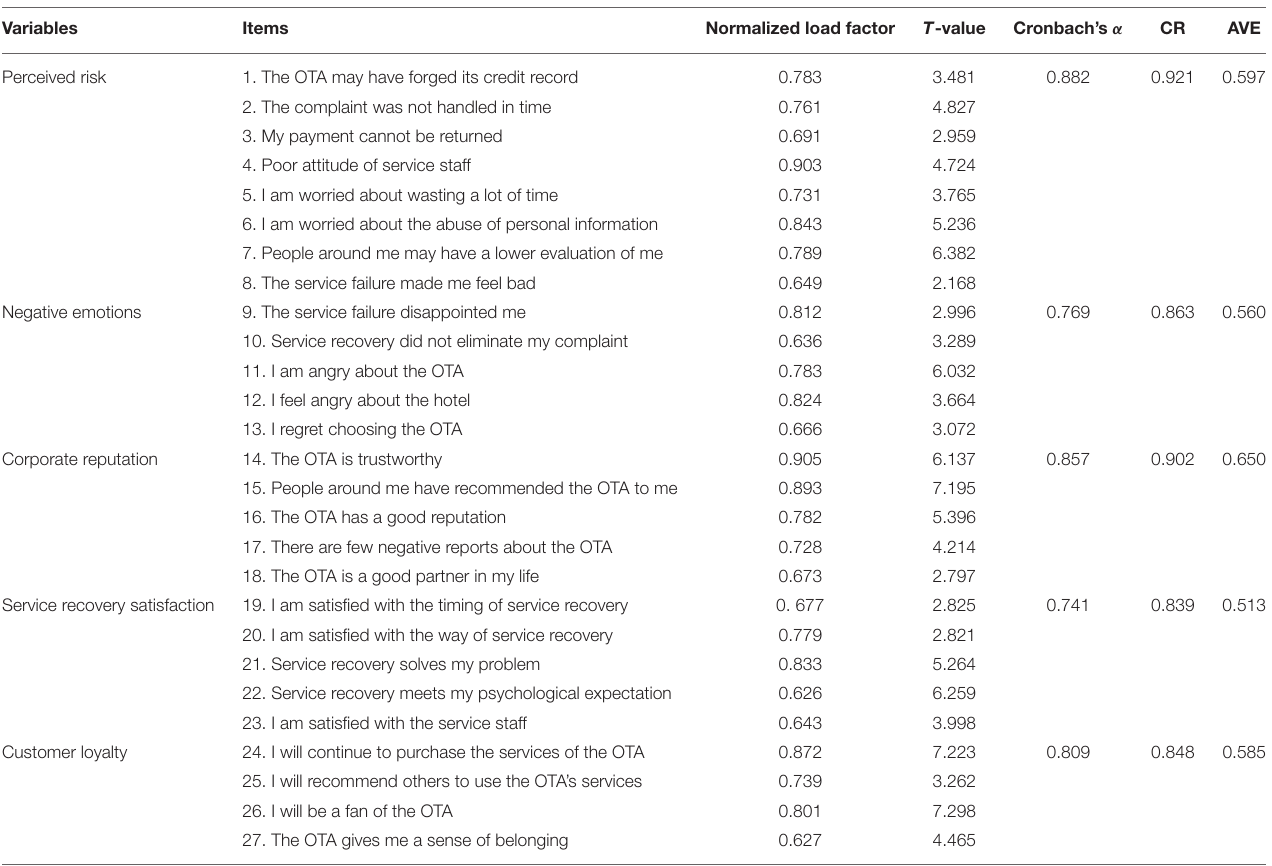
TABLE 2 | Test for reliability and convergent validity.